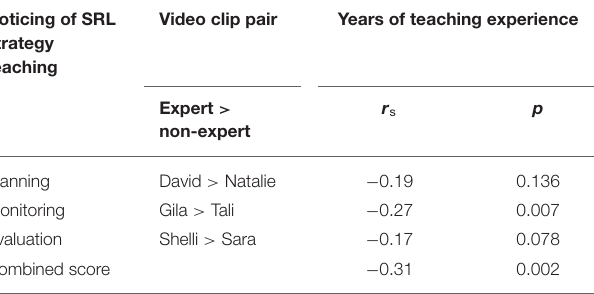
TABLE 3 | Spearman rank-order correlations between inservice teachers’ years of teaching experience and their noticing of videotaped teachers’ explicit instruction of self-regulated learning (SRL) strategies ( N =